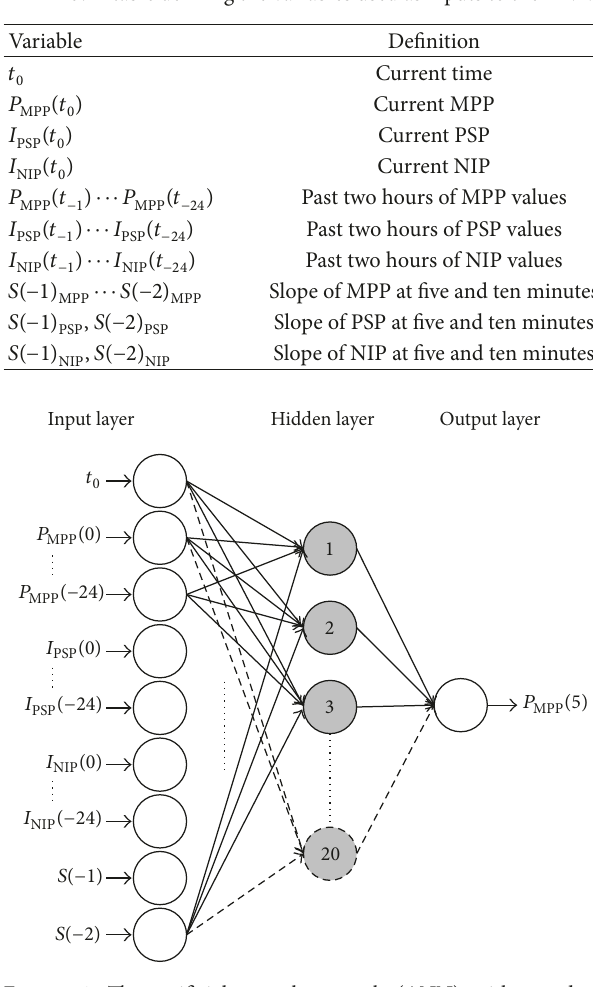
Figure 1: The artificial neural network (ANN) with standard preprocessing contains two previous hours’ worth of measurements and two slopes as input and a twenty-minute prediction